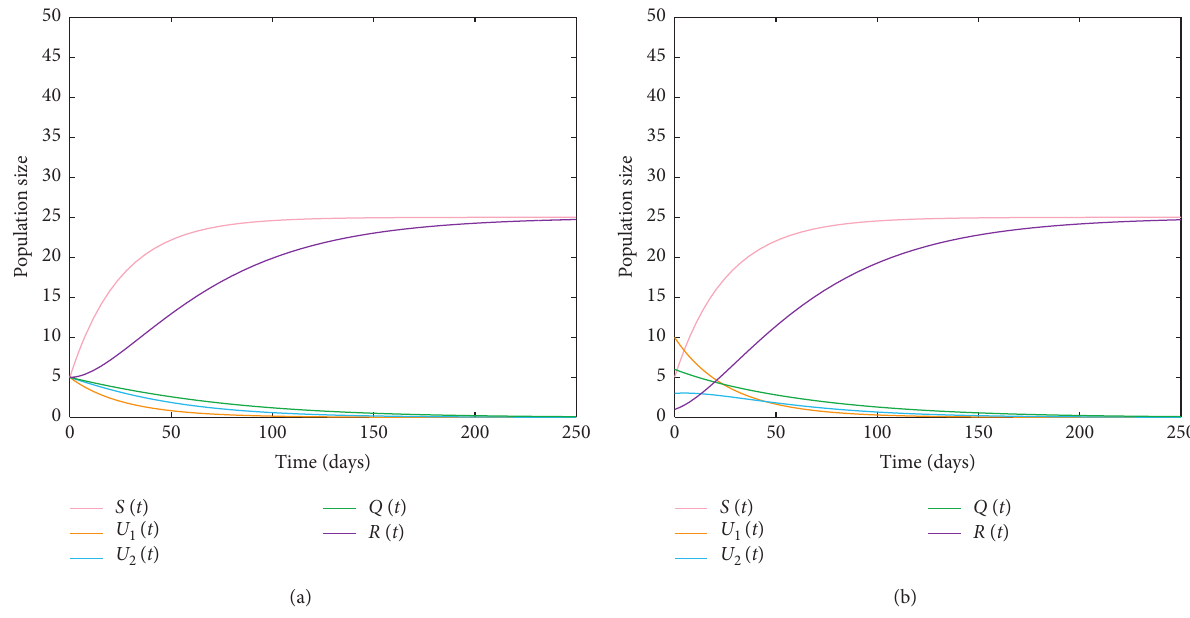
Figure 2: The stability of E an initial value I 2 .